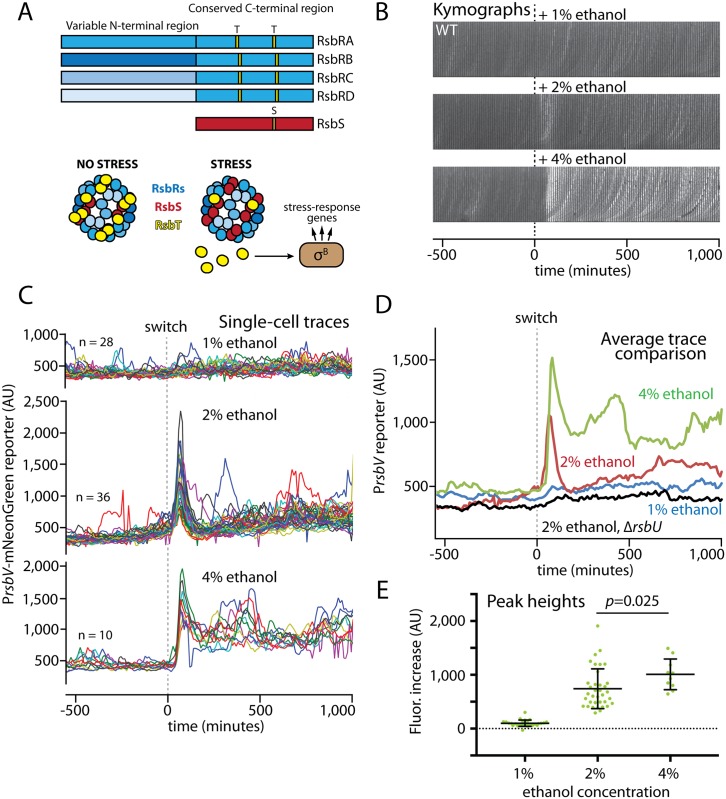
Environmental stress levels elicit different response profiles in wild-type cells.A. Schematic of the four RsbR paralogs and RsbS, showing variable and conserved domains with RsbT-phosphorylatable S/T residues (orange). Wild-type cells presumably have mixed populations of RsbR proteins (different shades of blue) in their stressosomes. Stress leads to RsbT release and subsequent σB activation (also see Fig 1). B. Kymographs of single representative wild-type (MTC1801) cell lineages growing in microfluidic channels before and after addition of the indicated ethanol concentrations (dashed line) to induce environmental stress. C. Single-cell intensity traces of a stress-responsive PrsbV-mNeonGreen reporter before and after (dashed line) the addition of ethanol at the indicated concentrations. D. Overlaid average intensity traces of the cell populations in C showing different ethanol concentrations, together with the average trace of a control ΔrsbU (environmental stress-negative) strain upon 2% ethanol exposure. The traces were manually curated to eliminate cell lineages with cell-death events or other anomalies; comparisons of mean traces for curated and uncurated populations are shown in S3 Fig. E. Distributions of signal increases in single cells from before stress exposure to their maximal peak values. All unmarked pairwise comparisons were significant (p < 3 x 10−6).